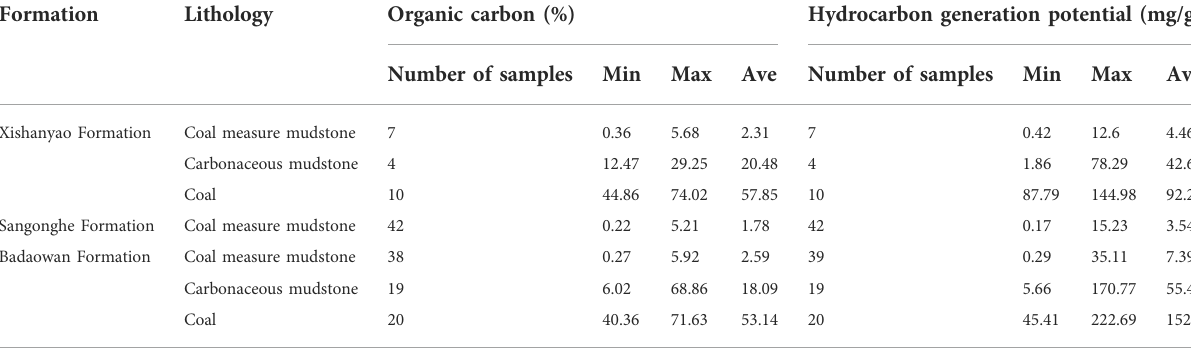
TABLE 2 Test results of organic carbon content and hydrocarbon generation potential of Jurassic source rocks in the Yanqi Basin.